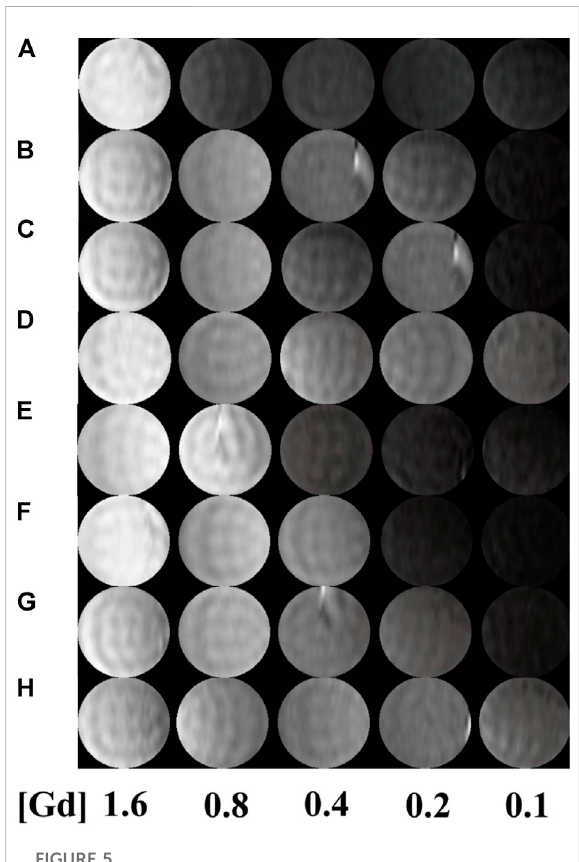
FIGURE 4 T 1 -weighted images of G5.NH 2 -DOTA 5 (Mn), G5.NH 2 - DOTA 10 (Mn), G5.NH 2 -DOTA 20 (Mn), and G5.NH 2 -DOTA 30 (Mn) (A, C,E,G) beforeand (B,D,F,H) afteracetylationasfunctionsofMn 2+ concentrations.